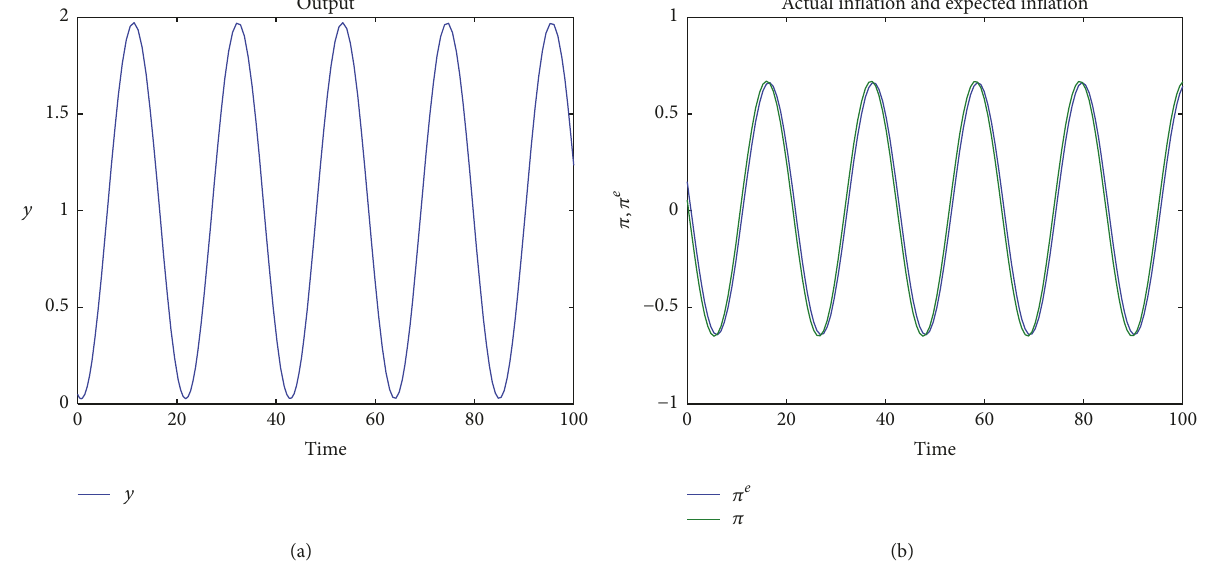
Figure 3: Simulation (2) . (a) Solution for 𝑦(𝑡) . (b) Solutions for 𝜋(𝑡) and 𝜋 𝑒 (𝑡) .